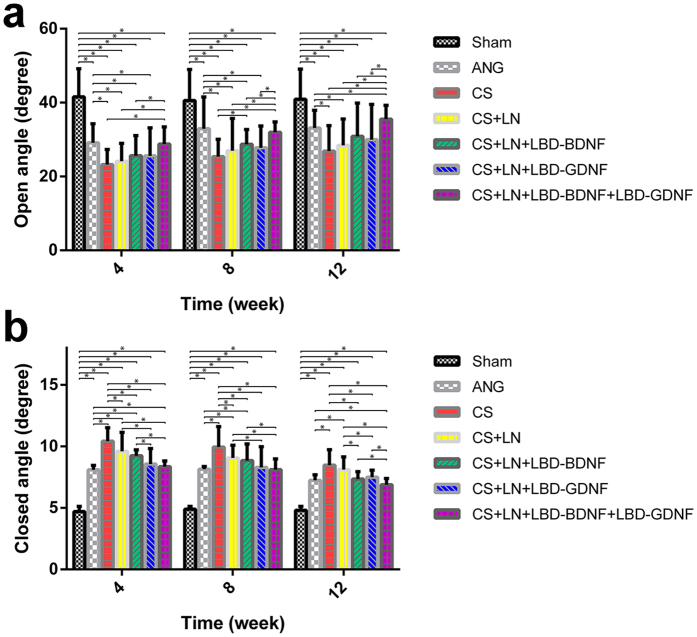
(a) Open and (b) closed angles between arytenoid cartilages during movement of the vocal fold. The arytenoid cartilages’ angles of the arytenoid cartilages improved over time. (a) The open angles measured 4, 8 and 12 weeks after surgery were 28.79 ± 4.63°, 31.97 ± 2.78°, 35.52 ± 3.78° of the CS+LN+LBD-BDNF+LBD-GDNF group, respectively. The open angle of the CS+LN+LBD-BDNF+LBD-GDNF group showed no significant difference compared to that of the ANG group at 4 and 8 weeks after surgery (P > 0.05); while the CS+LN+LBD-BDNF+LBD-GDNF group showed significant improvements compared to the ANG group at 12 weeks (P < 0.05). (b) The closed angles at week 4, 8 and 12 were 8.35 ± 0.46°, 8.11 ± 0.87°, 6.88 ± 0.51° of the CS+LN+LBD-BDNF+LBD-GDNF group, respectively. Twelve weeks after surgery, the CS+LN+LBD-BDNF+LBD-GDNF group showed markedly smaller closed angle compared to the ANG group (P < 0.05), although the angle remained worse than that of the Sham group (P < 0.05). n = 30. *P < 0.05.